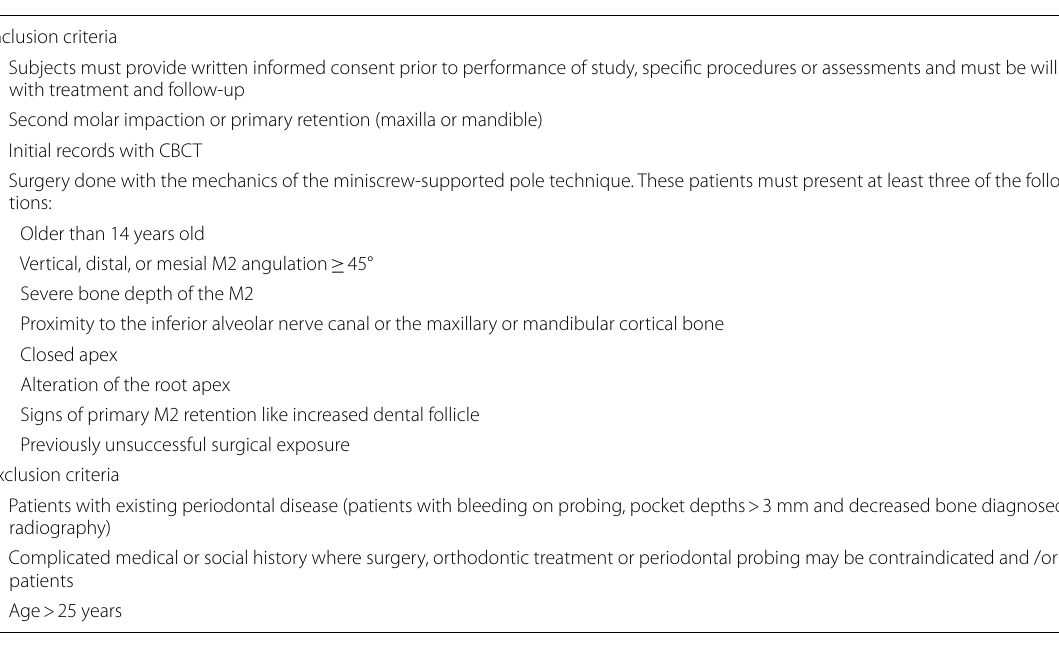
Table 1 Selection criteria Inclusion criteria